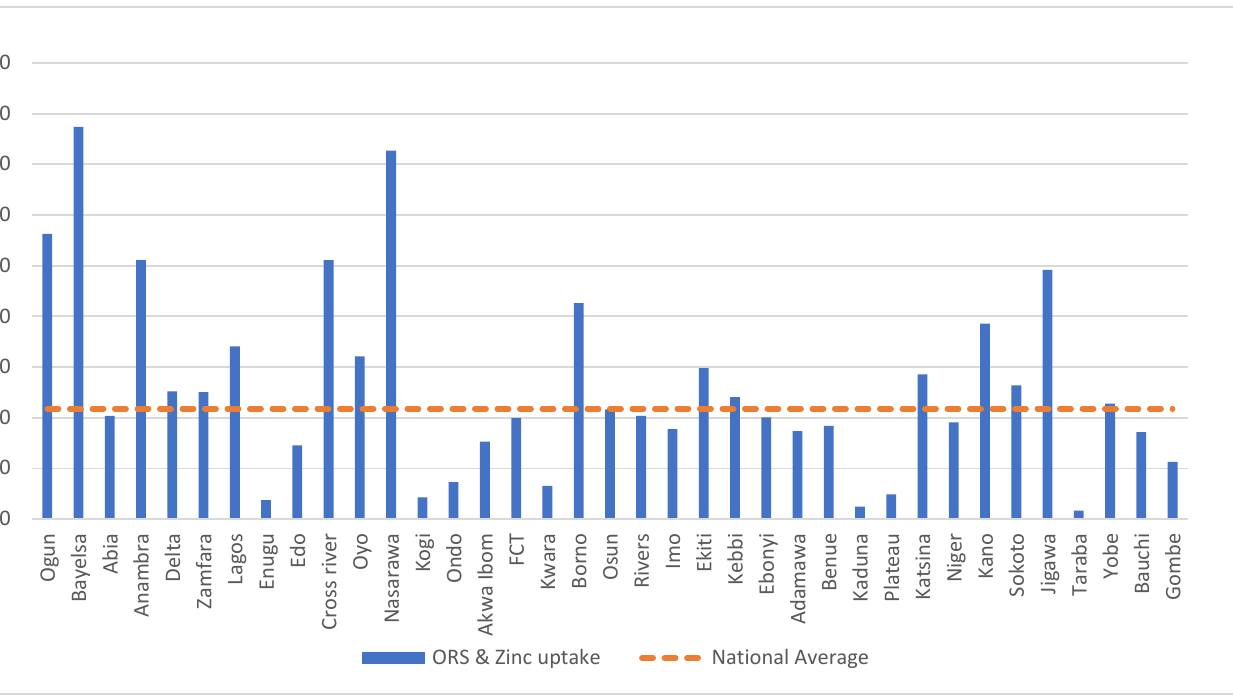
Figure 3. Percentage of children with diarrhea during the 2 weeks prior to the survey that were reported to have received oral rehydration solution (ORS) and zinc supplements by state compared to the national average of 21.8%.